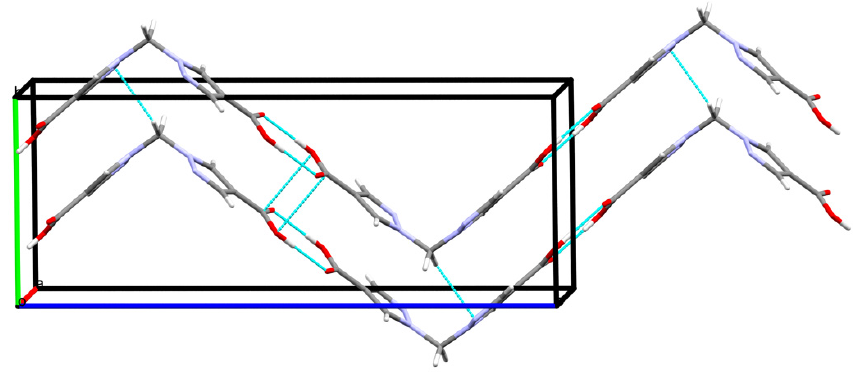
Figure 4. Hydrogen-bonded chains of H 2 bpmdc molecules. Table 1. Selected geometric parameters of the molecular structure of H 2 bpmdc.